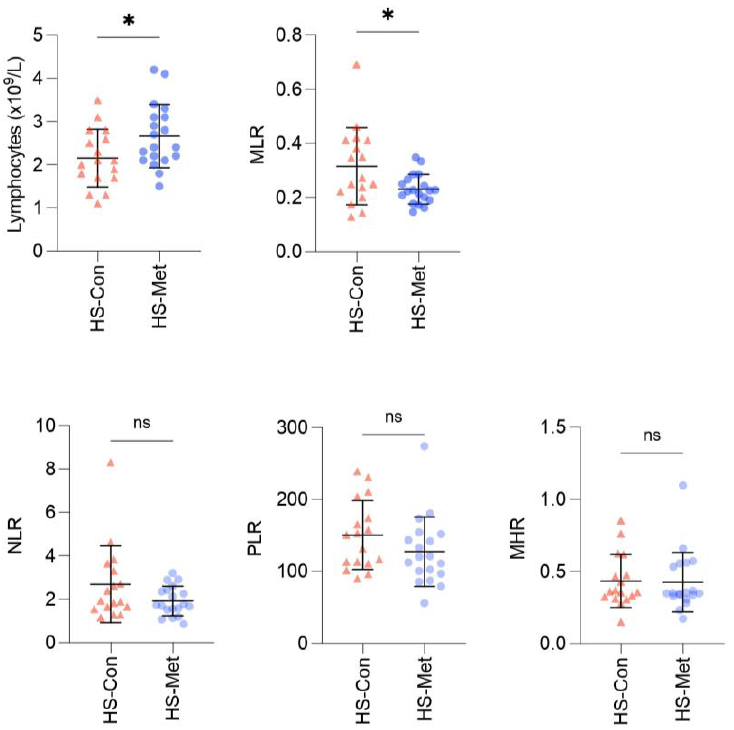
Figure 2. The absolute number of lymphocytes was higher in HS patients taking metformin than HS controls and the monocyte–lymphocyte ratio (MLR) was lower in those taking metformin than controls. Blood samples from control HS patients ( n = 17) and those taking metformin ( n = 19) were analysed for the absolute number of lymphocytes, the monocyte to lymphocyte ratio (MLR), neutrophil–lymphocyte ratio (NLR), platelet–lymphocyte ratio (PLR), and monocyte–HDL ratio (MHL). Graphs represent individual results, mean and standard deviation. Statistical significance was calculated using independent samples t -test. * p < 0.05. ns = not significant. MHR = monocyte–HDL ratio (HDL = high-density lipoprotein); MLR = monocyte–lymphocyte ratio; NLR = neutrophil– lymphocyte ratio; and PLR = platelet–lymphocyte